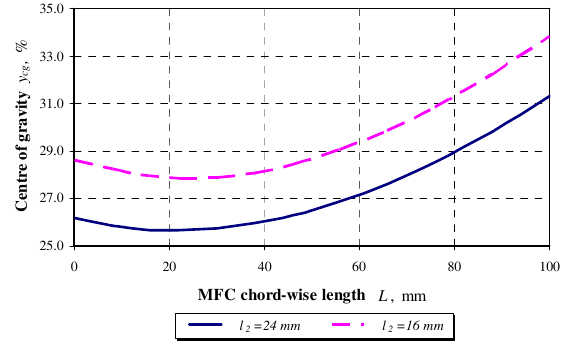
Fig 7. Influence of MFC chord-wise length on centre of gravity